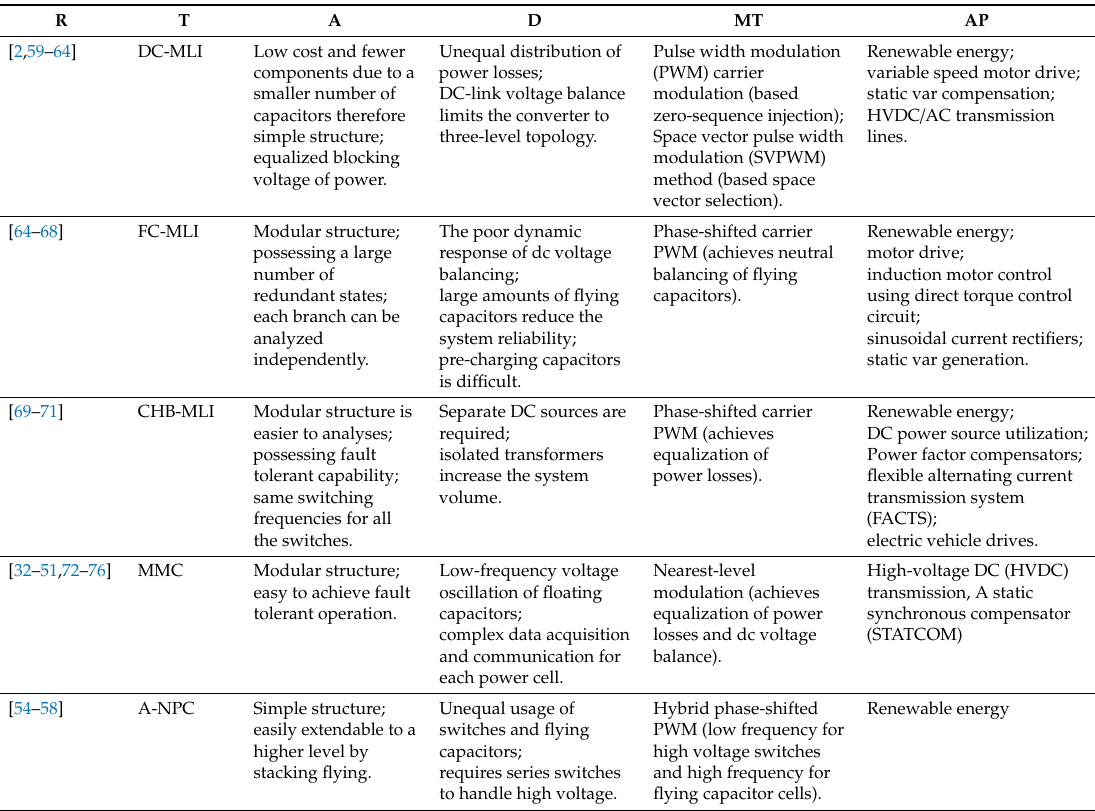
Table 8. Performance summary of multilevel